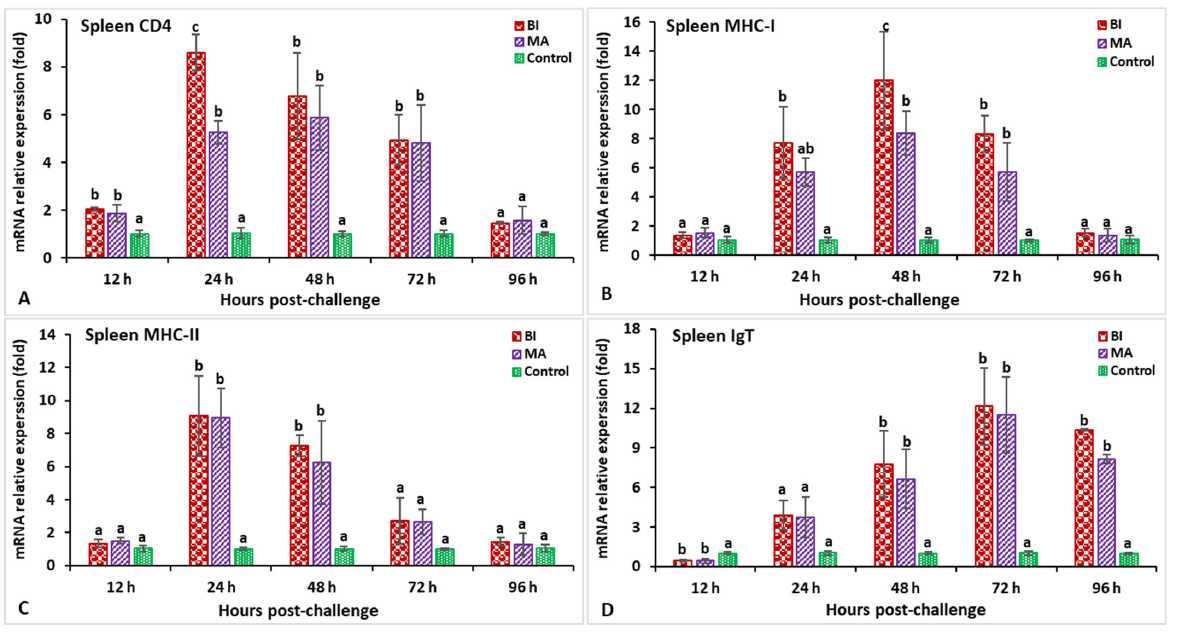
Figure 10. The gene expression of CD4 ( A ), MHC-I ( B ), MHC-II ( C ), and IgT ( D ) in the spleens of orally vaccinated fish after being challenged by Aeromonas hydrophila (mean ± SE, n = 3). Dissimilar letters denote significant differences ( p < 0.05).